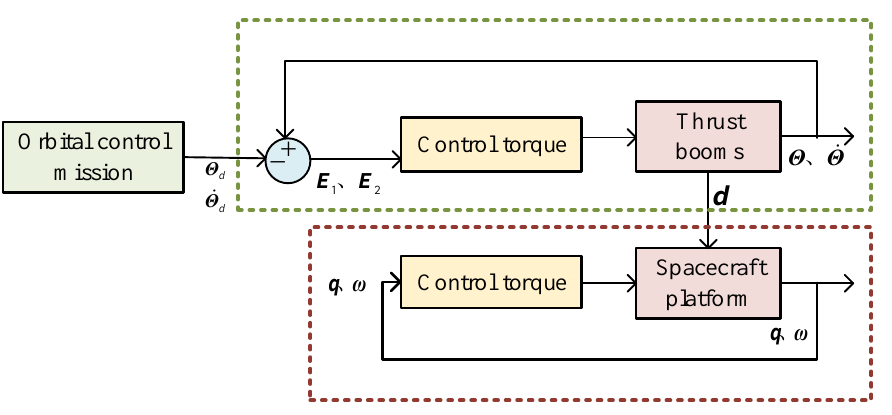
Figure 1. Electric engines spacecrafts with thruster booms [6].